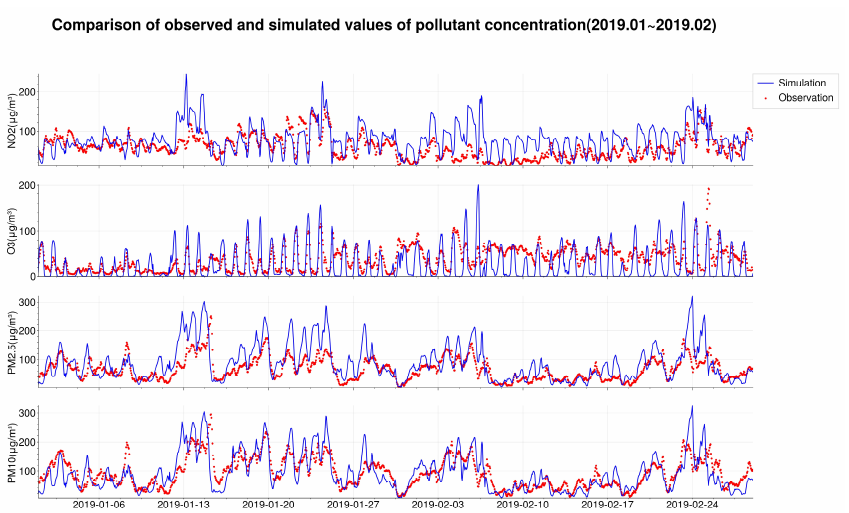
Figure 2. Hour-by-hour near-surface NO 2 , O 3 , PM 2.5 , and PM 10 ( µ g/m 3 ) concentrations in Nanjing from 1 January to 28 February 2019, for observed (red dots) and simulated (blue line) values.